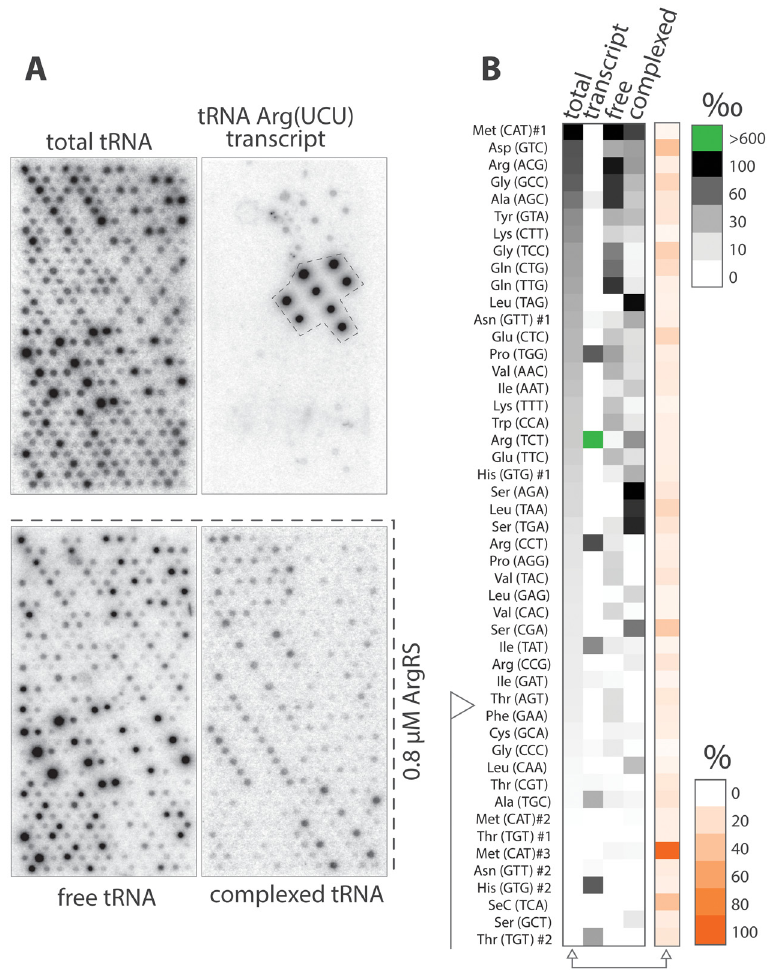
Fig 3. Microarray analysis of complexed tRNAs. (A) From top to bottom, in house printed tRNA microarrays hybridized with yeast radiolabeled: (i) total tRNA, (ii) in vitro transcribed tRNA Arg (UCU) (as a cross-hybridization control), (iii) free and (iv) complexed tRNAs after separation in the presence of 0.8 μ M yArgRS and gel elution. Each array displays 384 spots corresponding to 48 probes replicated 8 times. (B) Radioactive signal of the four above-mentioned tRNA samples hybridized on the arrays. Relative signal intensity for each probe corresponds to the intensity of the probe (median of 8 spots) divided by the total intensity on the array expressed in per mille. Relative intensities are represented as shades of grey on the heat map. The probes are organized from high to low relative intensity in the total tRNA sample. The flag indicates the probes that were not considered for further analysis due to low signal intensity. Standard deviations of the 8 replicas for each probe in the total tRNA sample are indicated as shades of red.